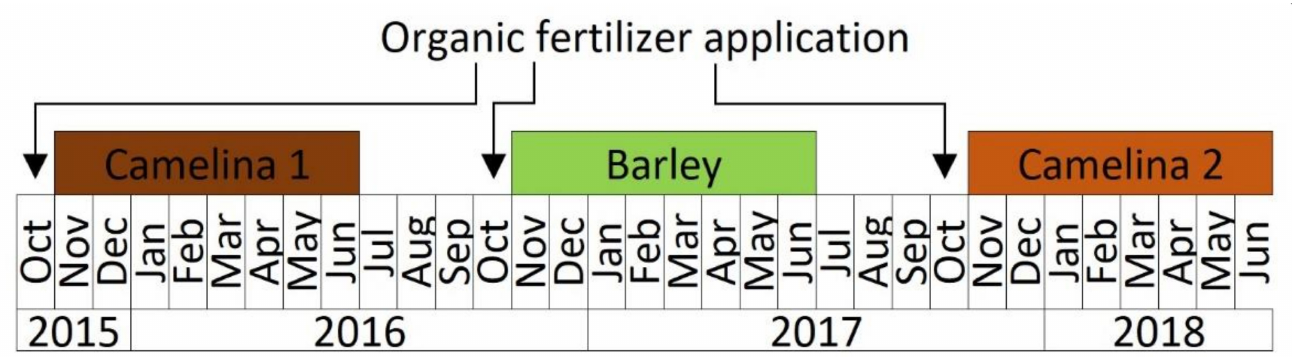
Figure 1. Experimental study of the crop rotation during three seasons considering three fertilization treatments. Camelina and barley were cultivated in a non-irrigated block design with three repli- cations of each treatment including the control. The total plot size per treatment was 180 m 2 (18 m × 10 m). Climatic conditions correspond to Mediterranean, classified as BSk on the Köppen–Geiger scale [33], characterized by mild winters and hot and dry summers [34]. Meteorological data were collected from a weather station located on the experimental site of La Canaleja belonging to the National Institute for Agricultural and Food Research and Technology (INIA). The average long-term climatic conditions of Madrid were obtained from the statistical weather and climate web page of Madrid [35]. According to the USDA classification, the soil present in the experimental field is a Calcic Haploxeralf